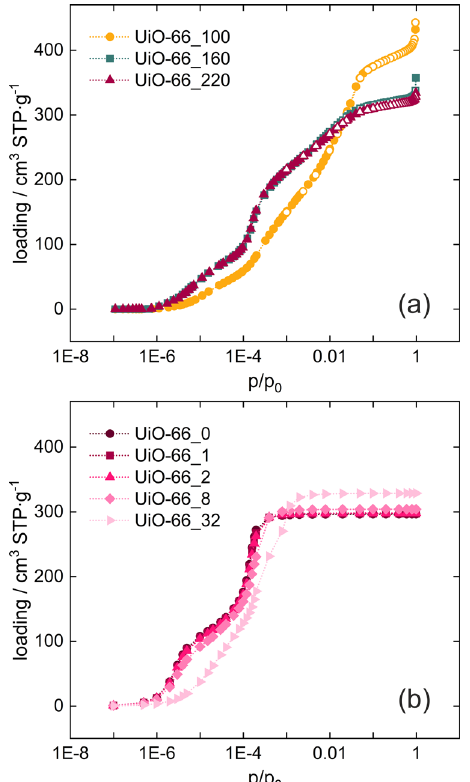
Fig. 5 Adsorption isotherms of argon in UiO-66. a From experiment 7 , b from calculations, measured/computed at − 186 °C. Closed symbols stand for adsorption, open for desorption. Table 3 Heats of adsorption of polar and nonpolar molecules in UiO-66 structures.